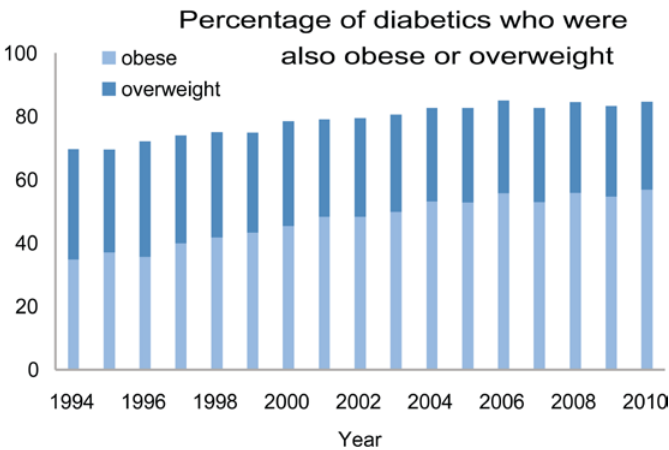
Figure 6. Age-adjusted percentage of US adults aged 18 years or older with diagnosed diabetes who were obese or overweight. Adapted from United States Centers for Disease Control, Diabetes Public Health Resource Statistics [16].